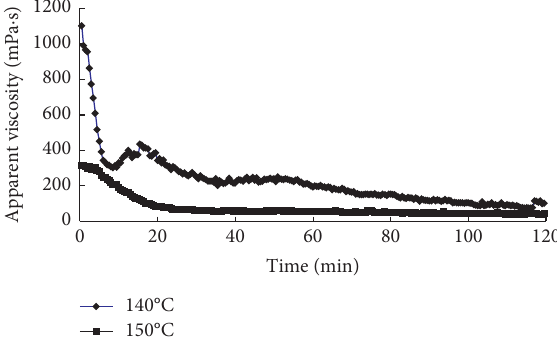
Figure 7: Temperature and shear resistance of the conventional density fracturing fluid of formula